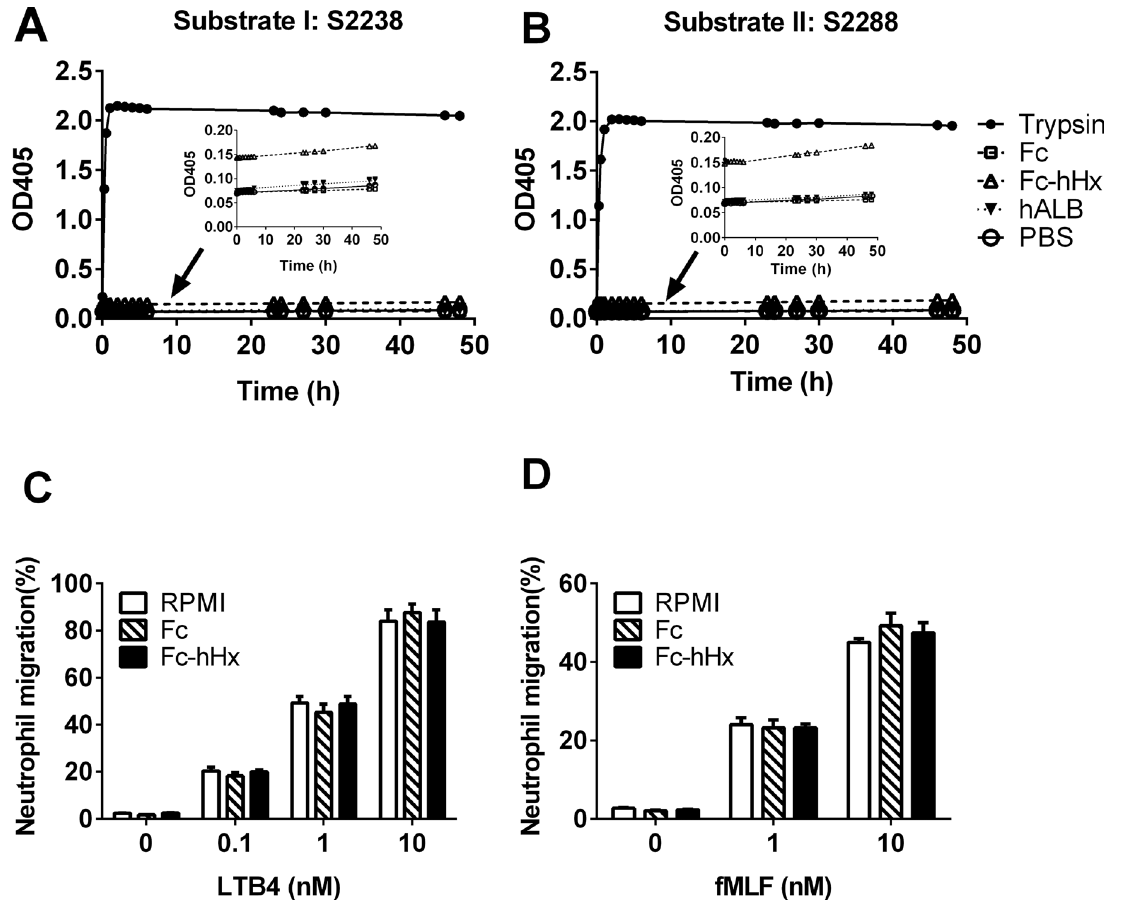
Figure 5. Recombinant Fc-hHx has minimal protease activity and no inhibition on the chemotaxis of human neutrophils induced by fMLF and LTB4. Enzymatic activity of recombinant Fc-human Hx (Fc-hHx) was tested by using chromogenic substrates substrate I: S2238 (A) and II: S2288 (B). Fc-hHx and the tag Fc at the concentration of 6.7 μ mol/L, positive control trypsin (0.4 μ mol/L), negative control human albumin (hALB) and PBS were mixed with the substrate at desired concentrations and incubated at 37°C for different times. The absorbance at 405 nm was measured by spectrophotometry. The small inserts are the sections with small scale and without trypsin control to show the very low increase of the absorbance by Fc-hHx. (C) and (D): Fc or Fc-hHx at 100 μ g/mL (1.67 μ mol/L) were also used to pretreat human neutrophils with control (RPMI 1640 containing 2% FBS) for 1 h. Then 1–2.5 × 10 5 cells/30 μ L cells were applied to the top of the transwell with the lower microplate filled with LTB4 (0.1 nmol/L, 1 nmol/L and 10 nmol/L) (C) or fMLF (1 nmol/L and 10 nmol/L) (D) and incubated for 1 h. Neutrophils migrated to the bottom microplate wells were stained with 0.4% trypan blue and live cells were counted. The percentage of cells migrated over the total cells uploaded to the top of the transwell was calculated. The results represent the mean ± SE and are representative of three independent